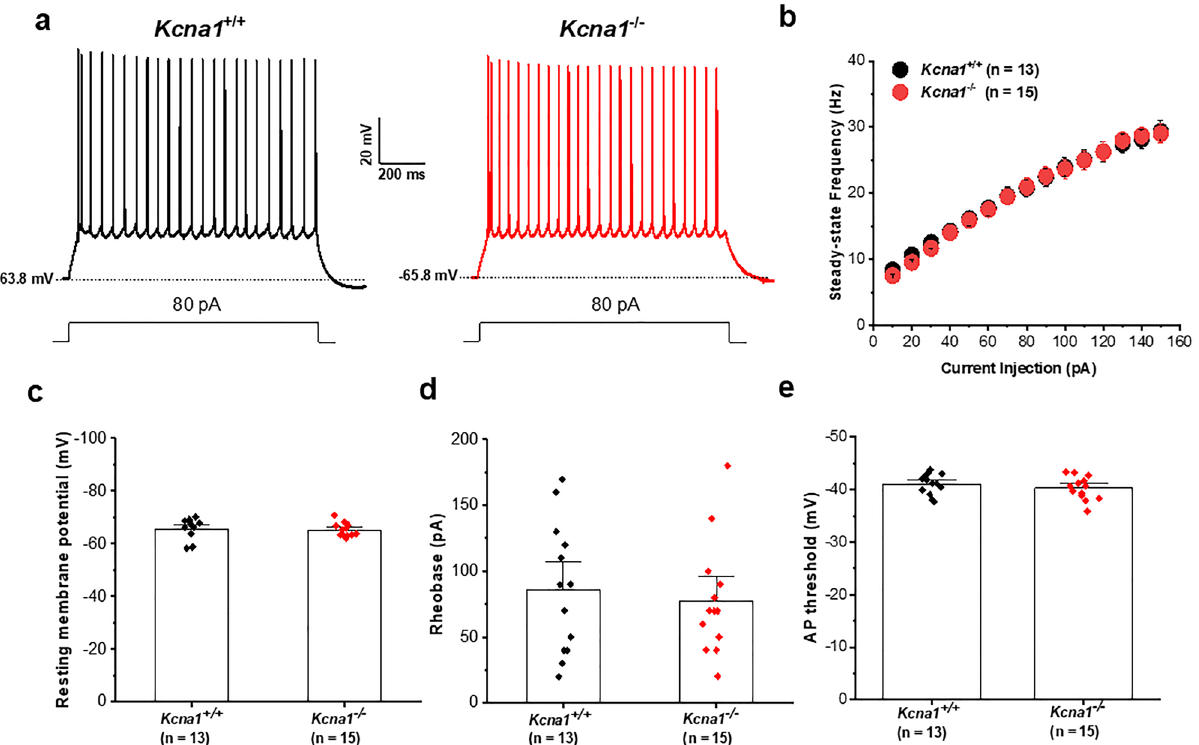
Figure 1. Lack of effect of K v 1.1 deletion on the intrinsic excitability of BLA pyramidal neurons. (a) Representative current-clamp recordings of BLA pyramidal neurons from both Kcna1 + / + (black trace) and Kcna1 −/− (red trace) mice recorded in response to a 80-pA stimulus. Dotted lines indicate the resting membrane potential. (b) Mean current–frequency ( f –I) plot showing firing frequency in response to current injections of increasing magnitude. There was no change in the firing frequency in BLA neurons from Kcna1 −/− compared to Kcna1 + / + mice. (c–e) Bar graphs show the average values of resting membrane potential ( c ), rheobase ( d ) AP threshold ( e ) and symbols represent the individual cell values. No significantly difference was obtained ( p > 0.05). Kcna1 + / + , n = 13 cells from 5 mice; Kcna1 −/− , n = 15 cells from 4